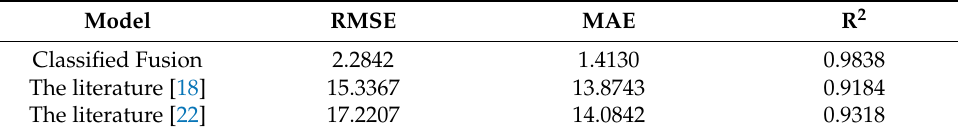
Figure 16. Predicted results of the paper and the literature [18,22]. (Note: model 1 is the reconstruction of model [18], and model 2 is the reconstruction of model [22]). Table 6. Evaluation indexes of the paper and the literature [18,22].